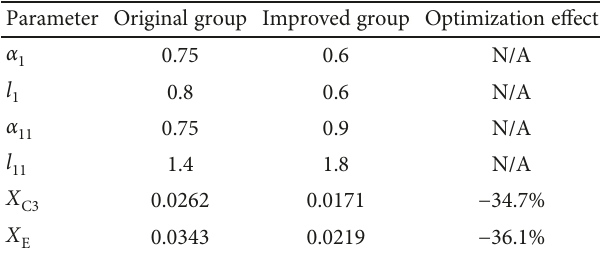
Table 4: Parameter optimization of the hollow shaft.